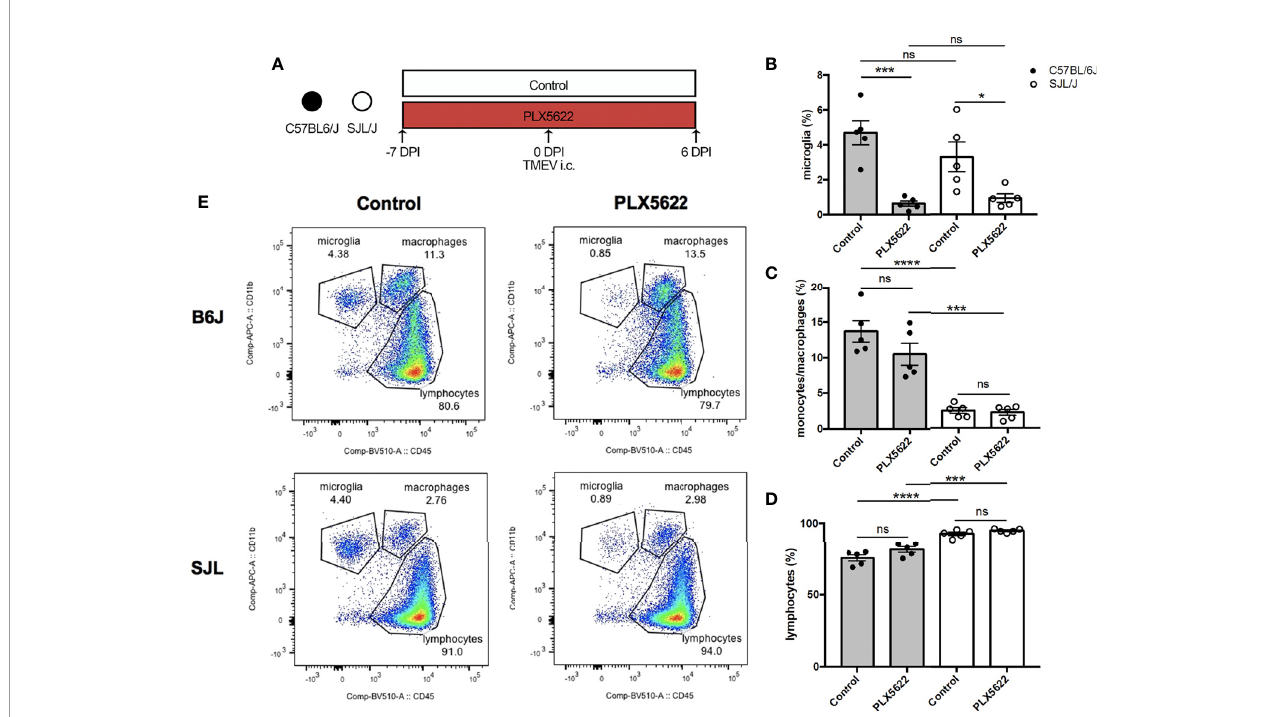
FIGURE 1 | Short-term PLX5622 treatment does not impede TMEV-induced recruitment of leukocytes into the CNS. (A) C57BL/6J mice and SJL/J mice were treated with a PLX5622-supplemented or control diet seven days prior to i.c. TMEV infection and sacri fi ced at 6 DPI for analysis (n = 5 mice per group). Proportion of (B) CD45 lo CD11b + microglia, (C) CD45 hi CD11b + monocytes/macrophages, and (D) of CD45 + CD11b - lymphocytes from the CNS (combined brain and spinal cord). (E) Representative fl ow plots demonstrating the gating strategy for CNS leukocytes. Data are presented as mean ± SEM. *P ≤ 0.05, ***P ≤ 0.001, ****P ≤ 0.0001, ns, not signi fi cant; one-way ANOVA for (B – D)